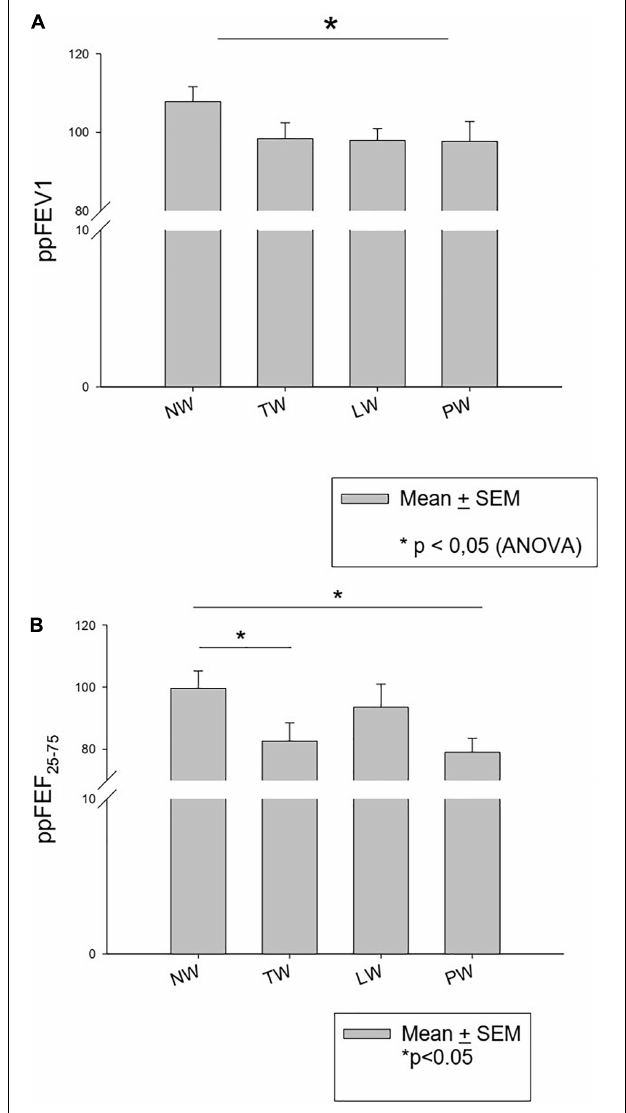
FIGURE 4 | ppFEV 1 (A) and ppFEF 25 − 75 (B) at the age of 6 years according to the TUCSON wheezing